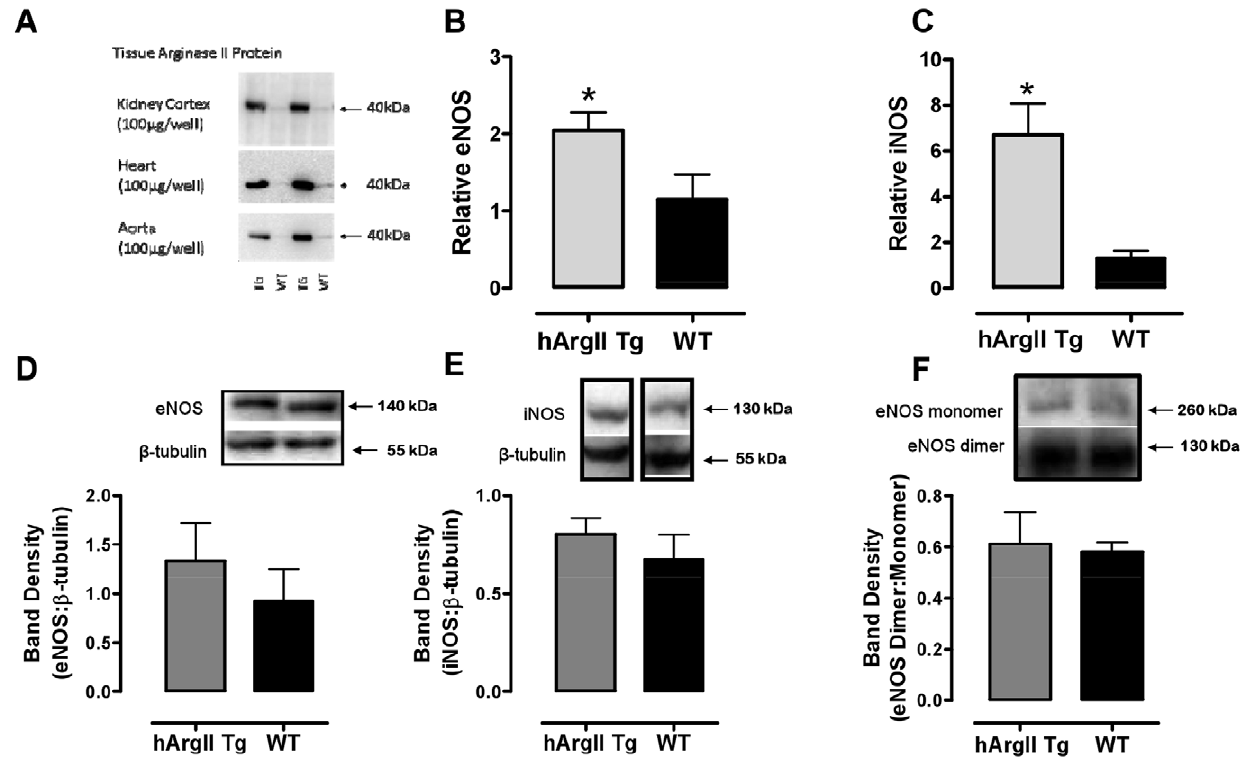
Figure 1. Representative western blot analysis of arginase II in A kidney, heart and aorta of male homozygous Line 11 hArgII mice (TG) and their WT littermate controls. Expression analysis of B eNOS and C iNOS using real-time quantitative RT-PCR and protein expression of D eNOS and E iNOS and F eNOS monomer:dimer ratio in aorta from male homozygous Line 11 hArgII mice and their WT littermate controls. Data are presented as mean 6 SEM; n=4 2 8. Values were compared with an unpaired Student’s t-test where *=P , 0.05. doi:10.1371/journal.pone.0039487.g001 PLoS ONE |